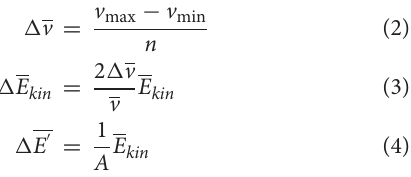
( Vogt Waffen AG, Oberglatt, Switzerland ). The external